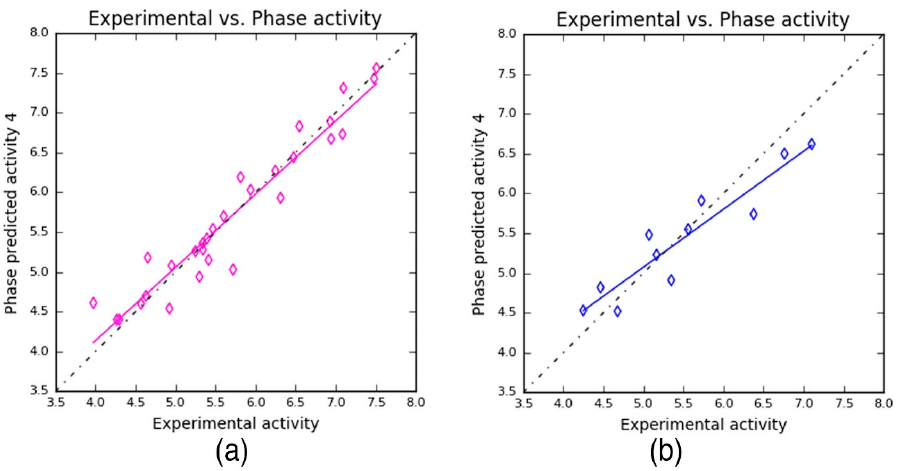
Figure 4. Scatter plots: The predicted activity values plotted against experimental values for ( a ) training set (y = 0.92x + 0.46 ( R 2 = 0.92)) and ( b ) test set (y = 0.73x + 1.43 ( R 2 = 0.87)) compounds.